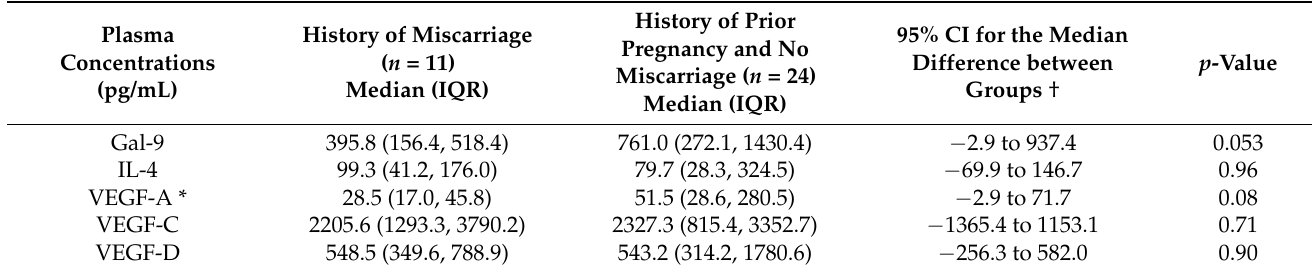
Table 3. Plasma concentrations in maternal blood from women with a history of miscarriage versus history of prior pregnancy with no history of miscarriage.